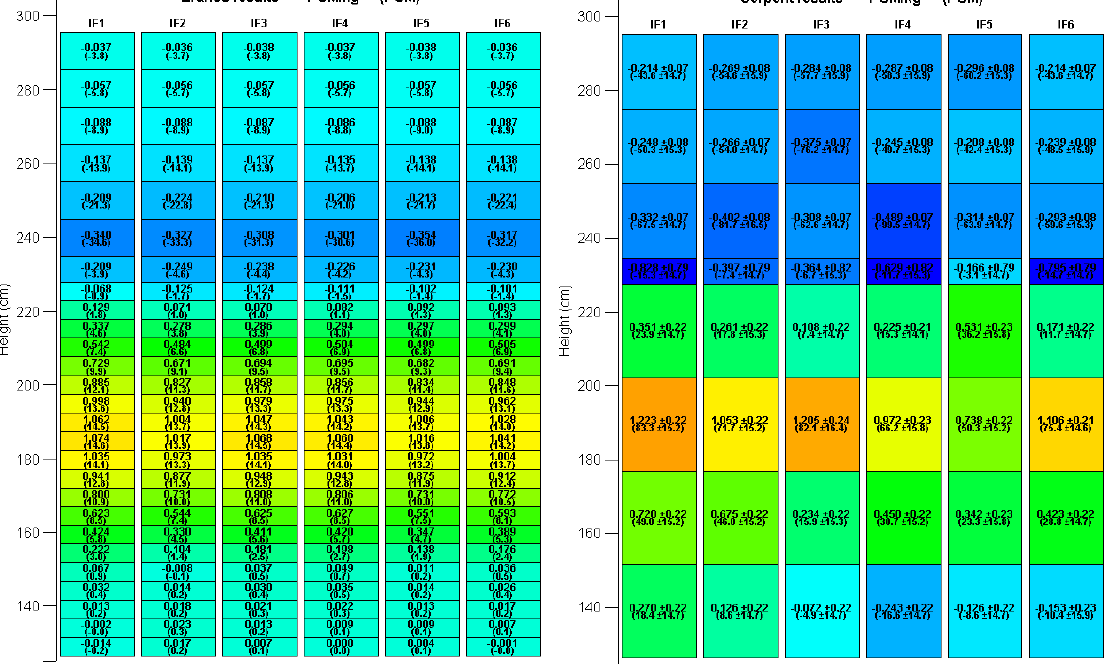
Figure 7. Void reactivity mapping for the six-batch core layout using the full core ERANOS model (left) and the radially infinite Serpent model